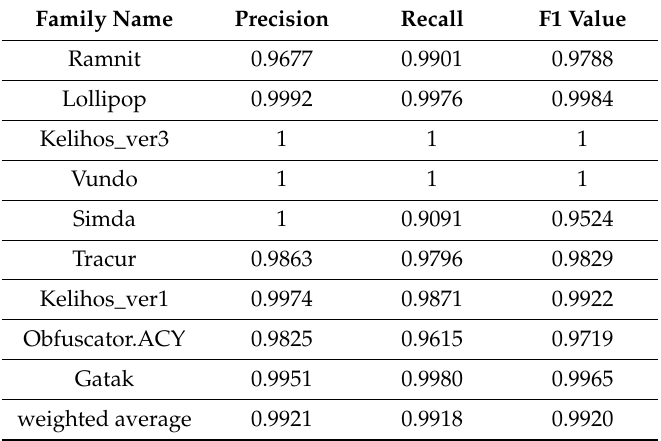
Table 4. The performance of the proposed model with